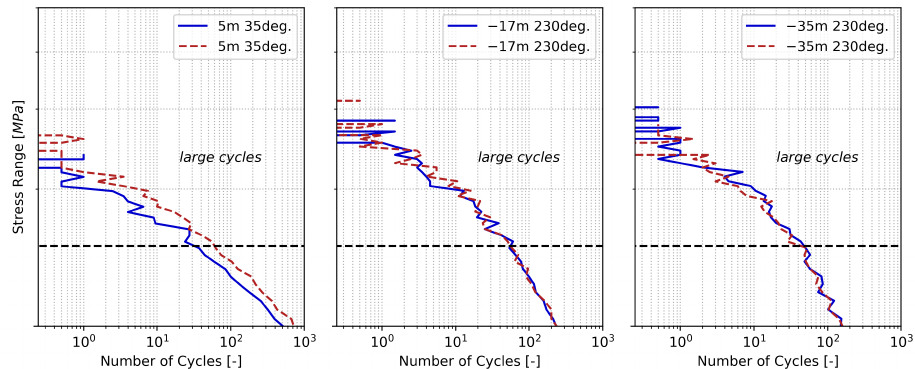
Figure 17. Zoom into fatigue spectrum of measurement (solid) and estimation (dashed), Left: Sensor of the dry zone. Center: Submerged sensor. Right: Sub-soil